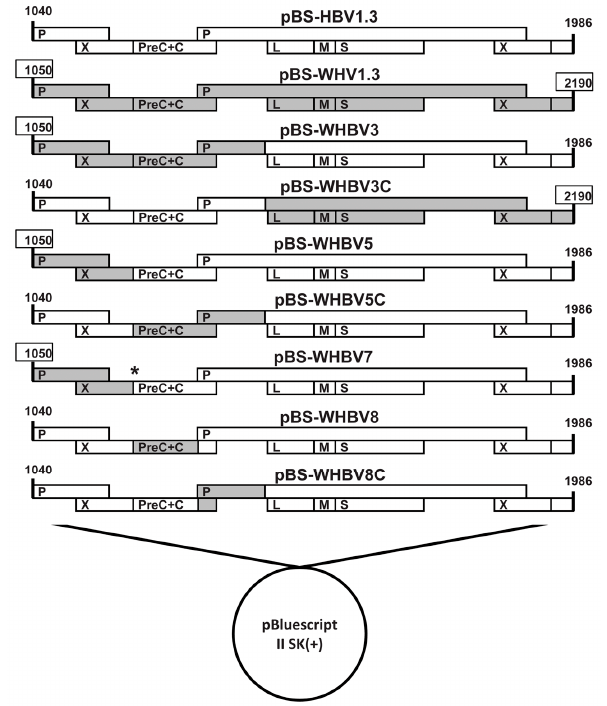
Figure 1. Recombinant woodchuck hepatitis virus ‐ hepatitis B virus (WHV ‐ HBV) genomes used in